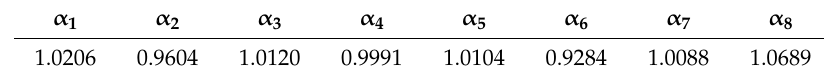
Table 3. Calibrated parameters for the plastic potential of the Q&P 980 steel ( m = 6) based on the averaged r -values.